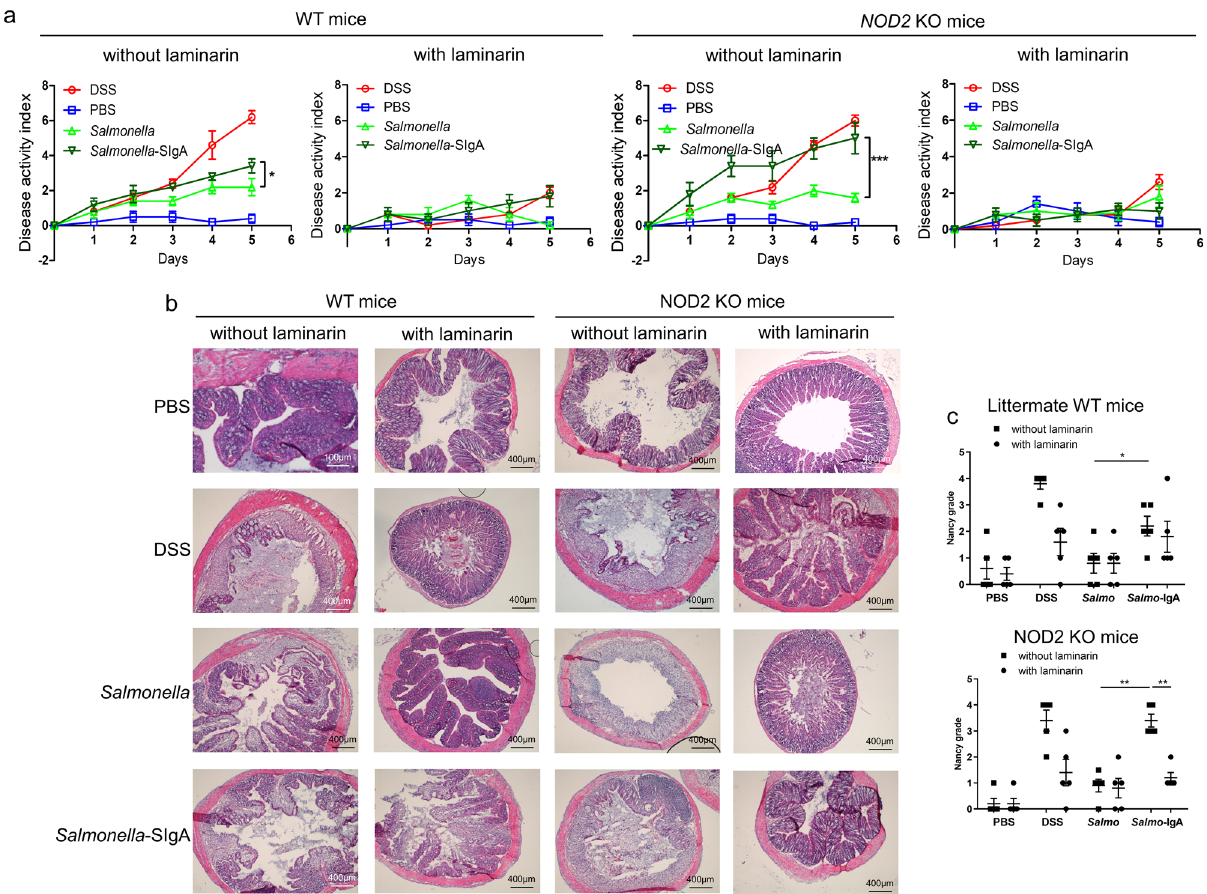
Fig. 3 SIgA- Salmonella amplify Salmonella -induced colitis in mice. Cohoused mice were challenged orally either with DSS, PBS, Salmonella Typhimurium or Salmonella Typhimurium bound with murine IgA. They were left untreated or treated with 5% laminarin in drinking water for 3 days prior to colitis challenge. a Disease activity index (DAI) score was undertaken daily to evaluate the clinical progression of colitis. The DAI was the combined score of weight loss compared to initial weight, stool consistency, and bleeding. Vertical bars show the mean value±SEM. n = 5 biologically independent mice per group. One-way ANOVA followed by Bonferroni post hoc test was used ( p values: * p < 0.05; *** p < 0.005). b Sections from the colon of mice showing neutrophil in fi ltrates in the lamina propria. This experiment was repeated on all mice showing similar results. c Nancy histological score applied in each colon section for littermate and NOD2 KO mice. n = 5 biologically independent mice per group. One-way ANOVA followed by Bonferroni post hoc test was used ( p values: ** p < 0.01). Source data are provided as a Source Data fi